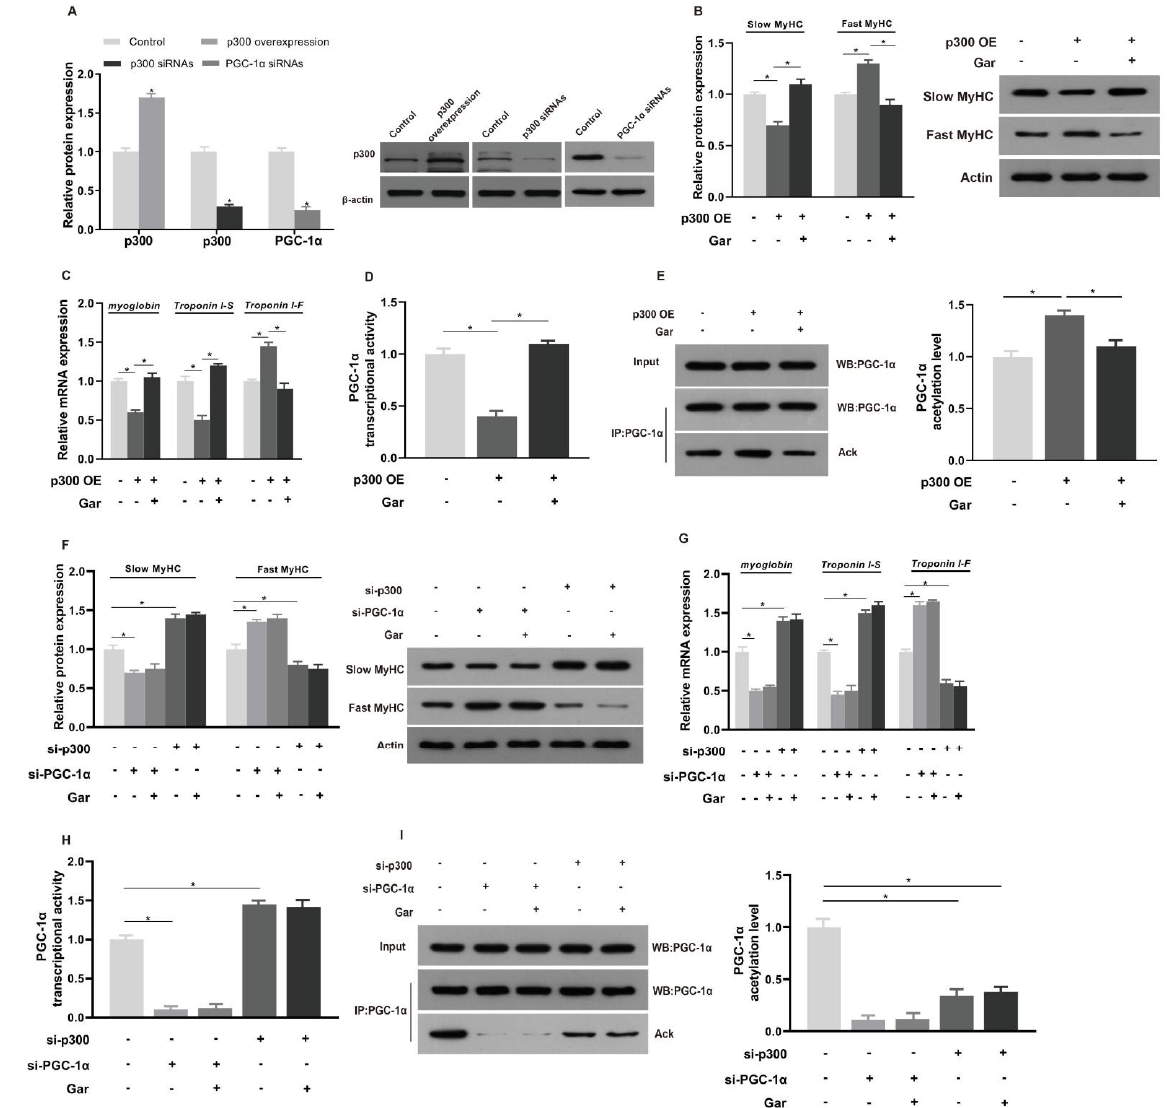
Figure 6. Effects and mechanisms of dietary garcinol on the protein expression of p300 ( A , B ), Slow MyHC, Fast MyHC ( C , D ), the activity of PGC-1 α ( E ), the acetylation level of PGC-1 α ( F ) in C2C12 myotubes. The mRNA expression of myoglobin, Troponin I-S, Troponin I-F ( G ), the activity of PGC-1 α ( H ), the acetylation level of PGC-1 α ( I ) in C2C12 myotubes were transfected with si-p300 or si-PGC-1 α . Data are shown as the mean ± SE, n = 10. * Different from the control group, p <